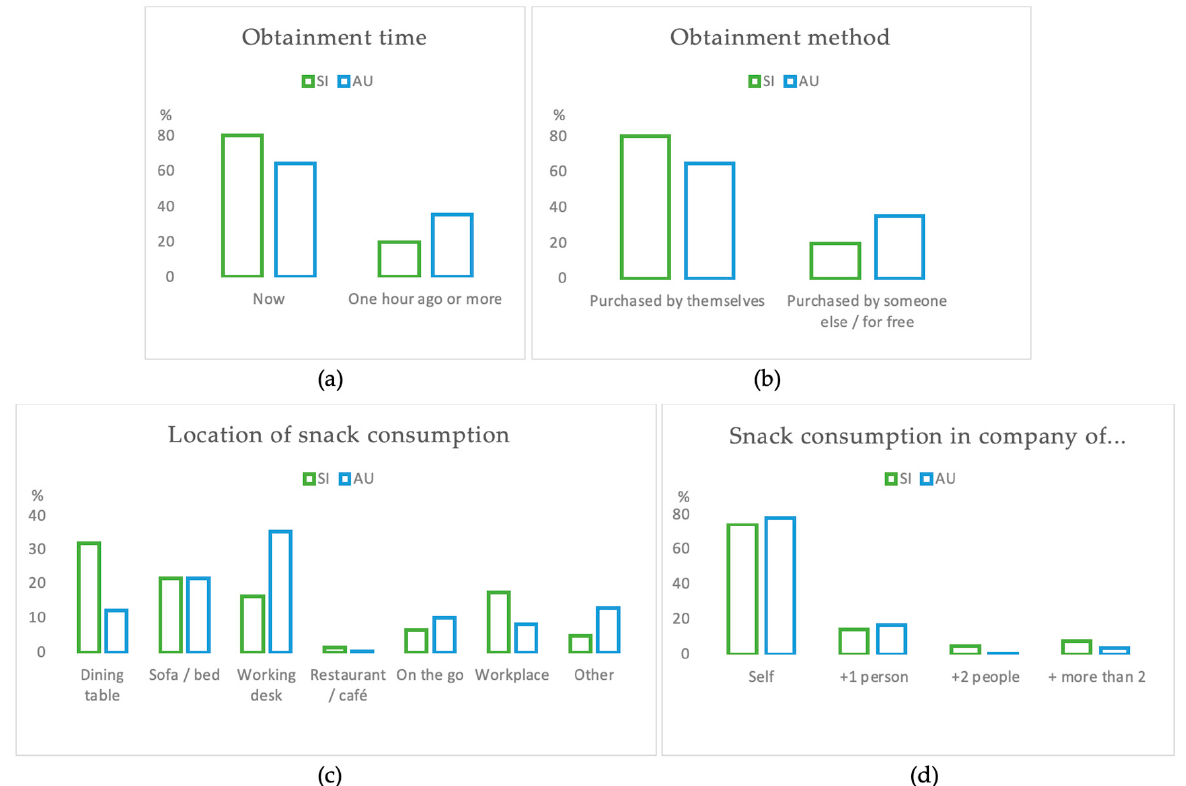
Figure 1. Results on the context of snack consumption: ( a ) Time of snack obtainment; ( b ) Method of snack obtainment; ( c ) Location of snack consumption; ( d ) How many people participants were with while eating the snacks.